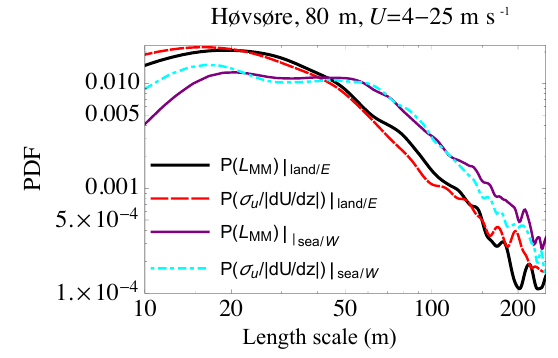
Figure 5. Probability density of turbulence length scale L MM from observations at Høvsøre over both the homogeneous land (eastern) sectors and inhomogeneous coastal (western) sectors. Black: L MM from fits to spectra over land; red/long-dashed: new simplified form (15) over land; purple: L MM from fits to spectra from off- shore; cyan/dot-dashed: new simplified form (15) from